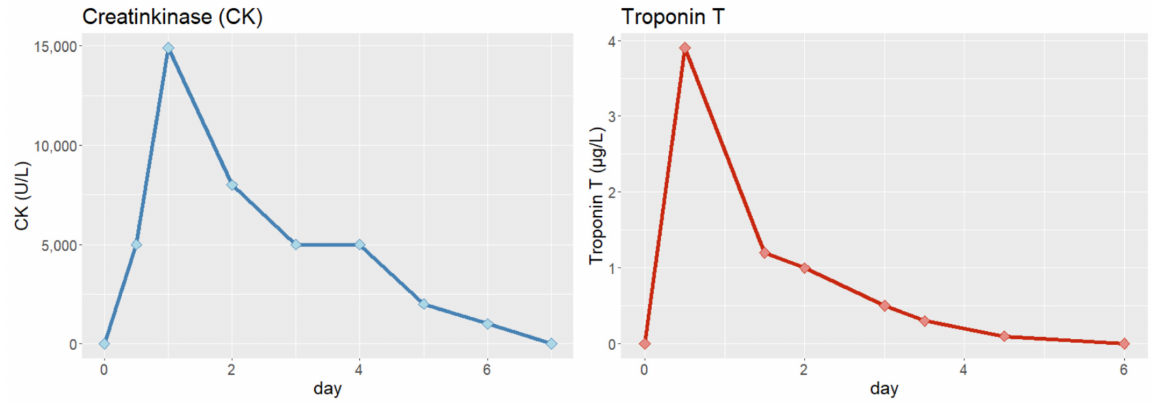
Figure 2. Trends of cardiac biomarkers during the first week after resuscitation. Coronary angiography demonstrated normal coronary arteries with no visible disease or luminal irregularities. Cardiac magnetic resonance (CMR) showed no evidence of arrhythmogenic right ventricular cardiomyopathy (ARVC). Cerebral CT and thoracic CT examinations were